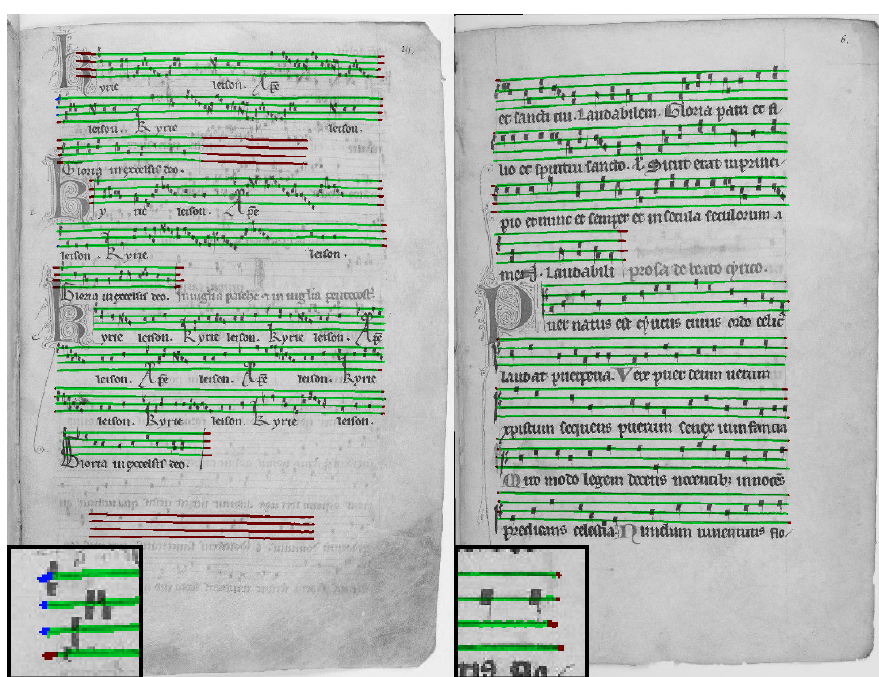
Figure 12. The left image shows typical errors during the staff line detection. Green pixels indicate TPs, red FPs, blue FNs. Either all lines in a staff are too long (third staff) or bled background is recognised (last staff). The right image shows a page with weak bleeding. In this image all staff lines are detected correctly. The zoomed sub images focus on the start and end of a staff.